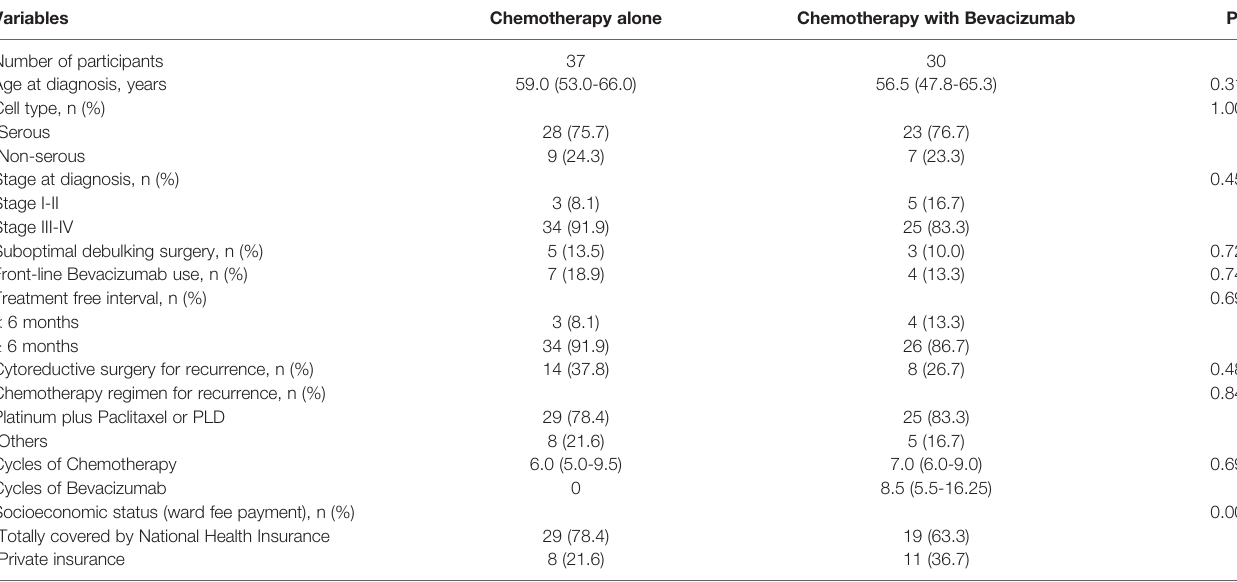
TABLE 1 | Characteristics of study participants according to Bevacizumab treatment for recurrence.